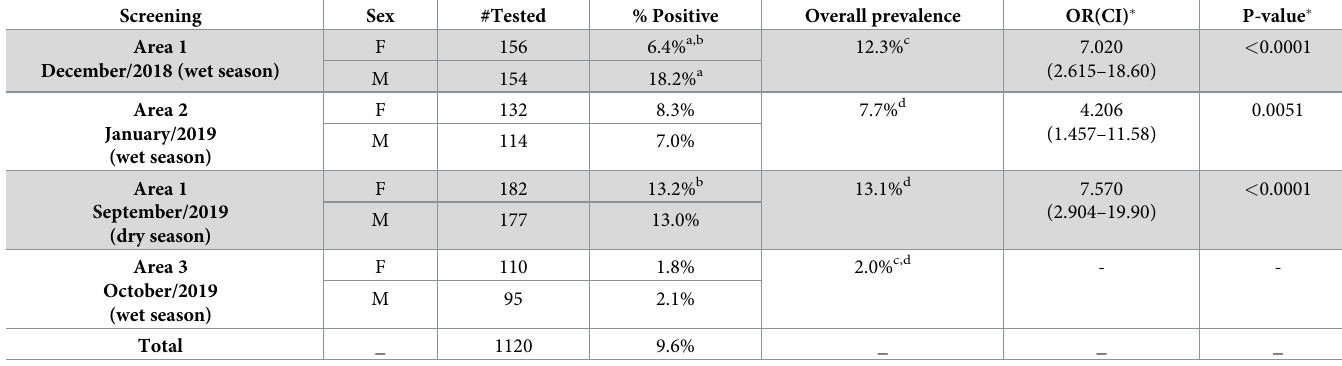
Table 1. General data on Screening of asymptomatic individuals. Screening